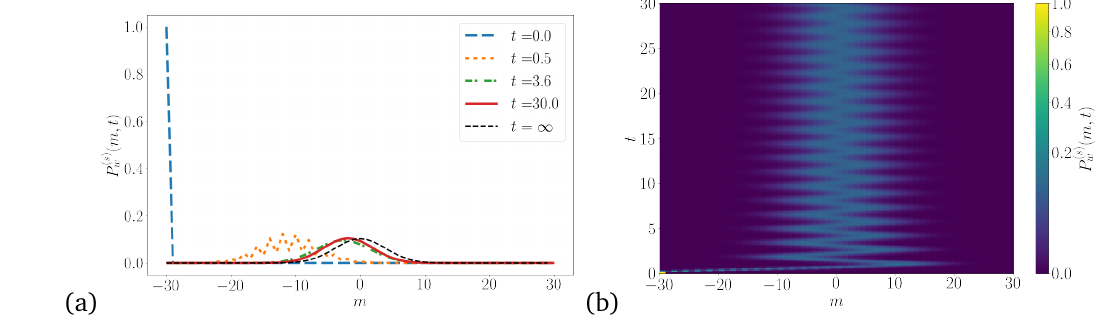
( m , t ) for a subsystem of size (cid:96) = 60 at times t = 0,1.4,30.0 for a Figure 17: P ( s ) w system initialized in a Néel state and time evolved with H ( h = 2 ) . The dotted lines are the asymptotic probability distributions given in